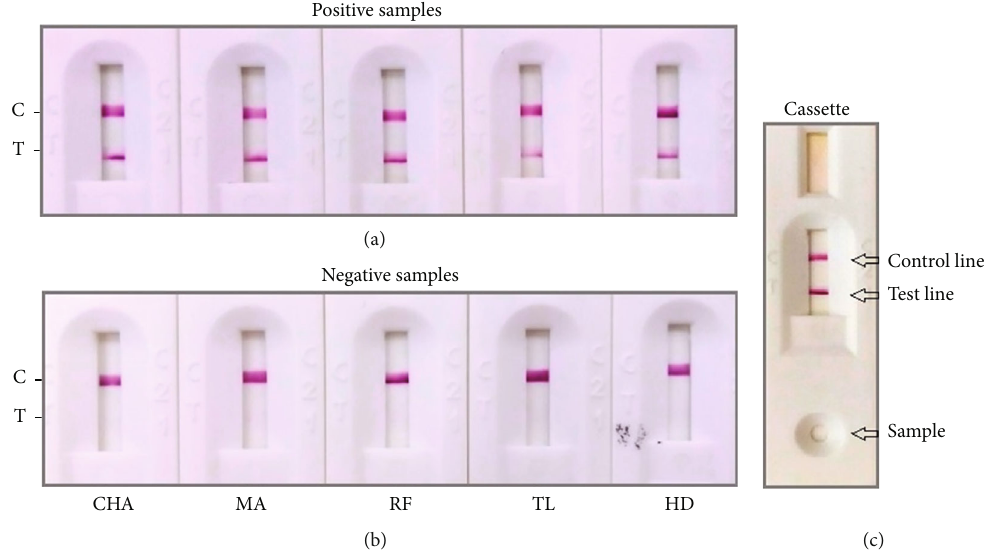
Figure 9: Illustrative results of detecting anti- Leishmania antibodies in sera and blood for VL diagnosis using the DTL-4-based ICT. (a) Sera samples from fi ve VL di ff erent patients were included in this assay as a positive control (visible test and control line). (b) Sera samples from negative donors for LV with a previous diagnosis (ten samples of each disease) of Chagas ’ disease (CHA), malaria (MA), rheumatoid factor (RF), tegumentary leishmaniasis (TL), and healthy donor (HD) were tested. These assays presented negative results (only the control line was visible). (c) Representative test on the cassette. The sera sample from the VL patient was applied, and the control and test lines were